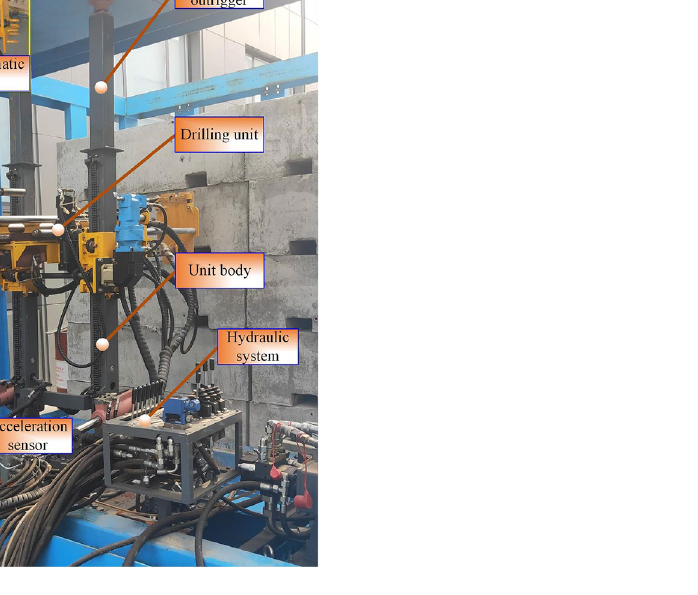
Figure 14. Anchorage system test